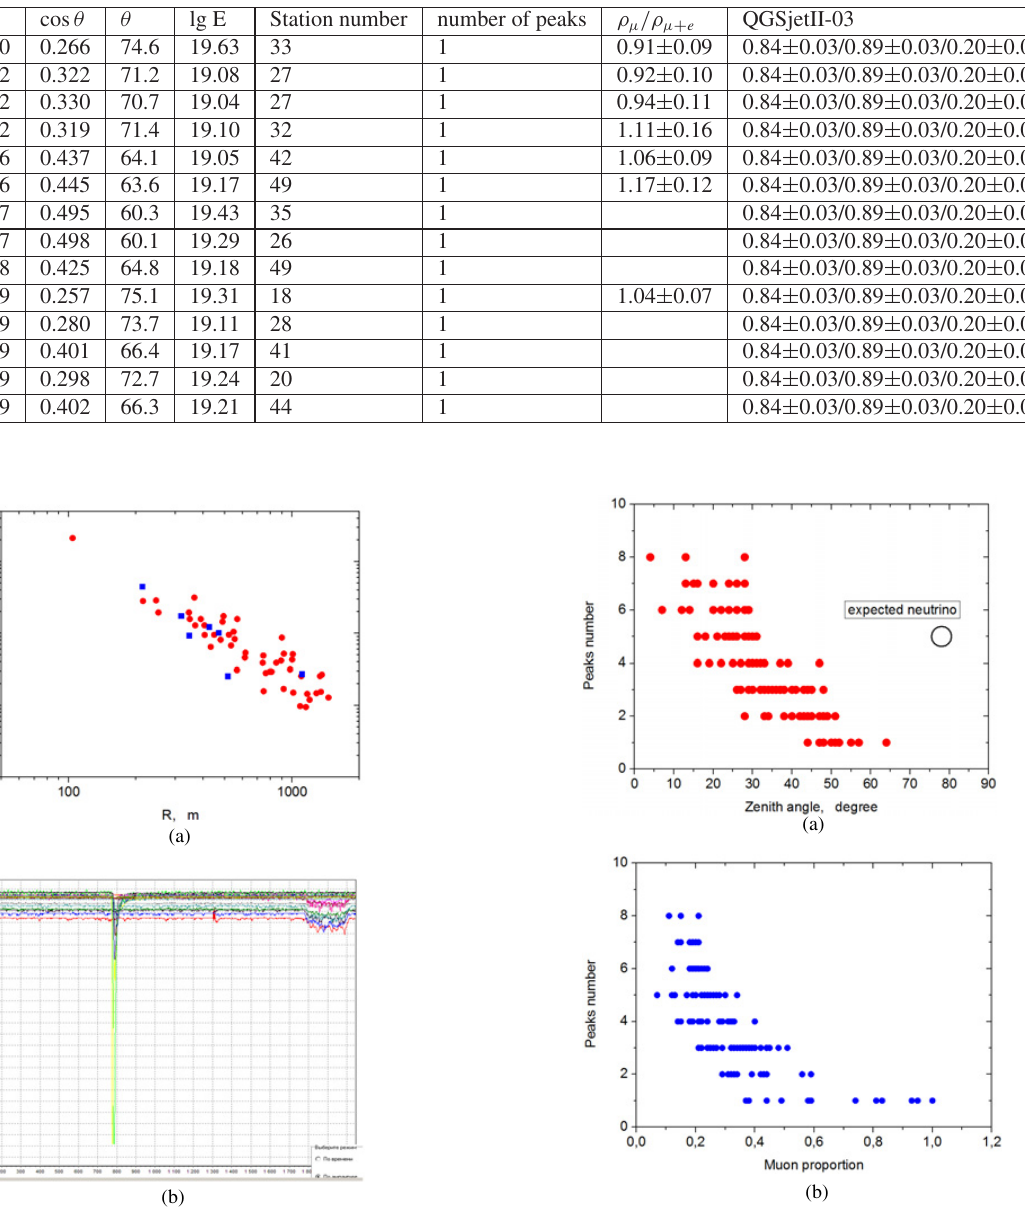
Figure 7. Number of peaks in the time sweep of scintillation detectors. a) Surface scintillation detector with threshold 10 MeV plotted against zenith angle b) underground scintillation detector with ε thr . ≥ 1